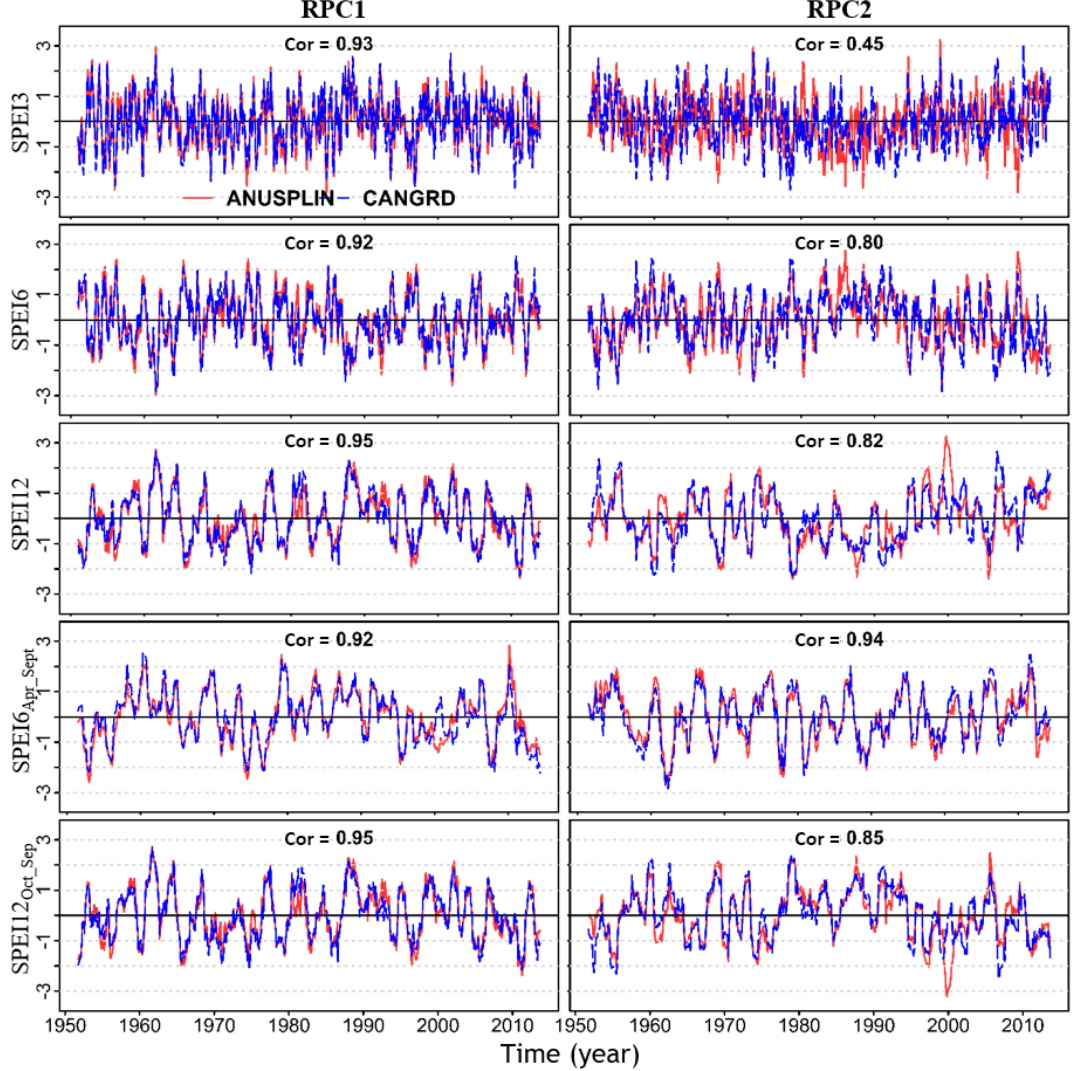
Figure 6. Temporal patterns (RPCs) of the first two rotated principal components (REOFs) of SPEI at various timescales. Indicated within each box is the pattern correlation between ANUSPLIN and CANGRD. Table 5. Dominant periods and the intervals of significant variance for SPEI6 Apr − Sep and SPEI12 Oct − Sep during